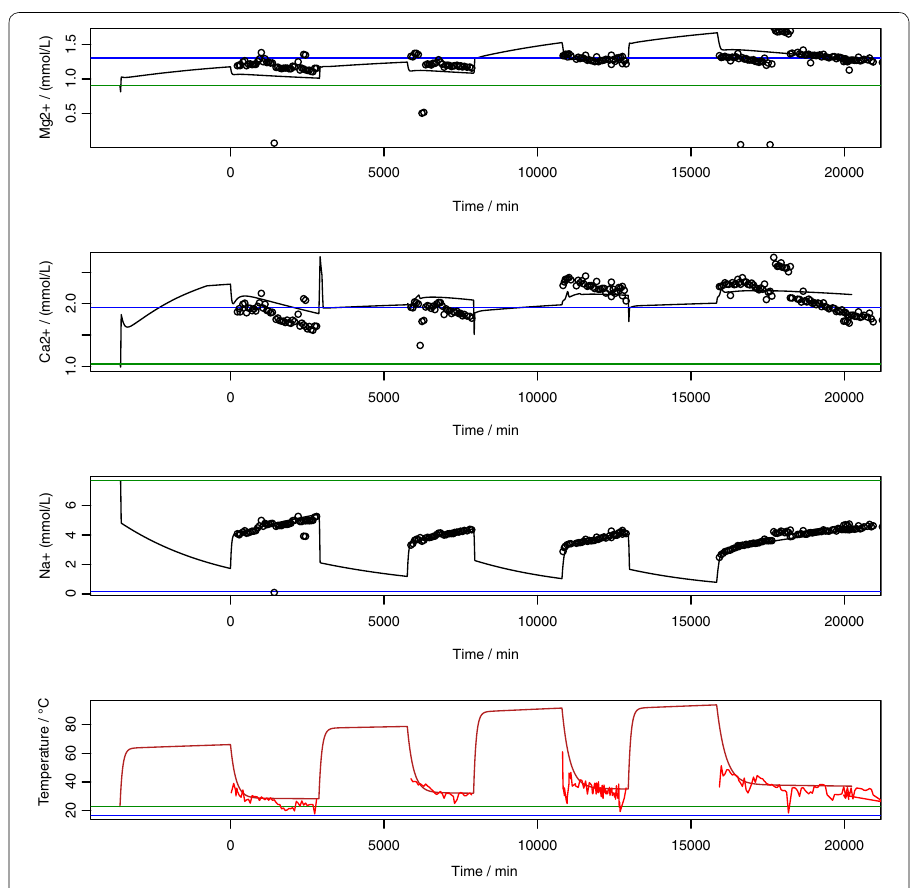
Fig. 16 Simulation results (lines) vs. measured values (black circles) of production stages 1–4. Values of the original aquifer water are shown as a green and those of tap water as a blue